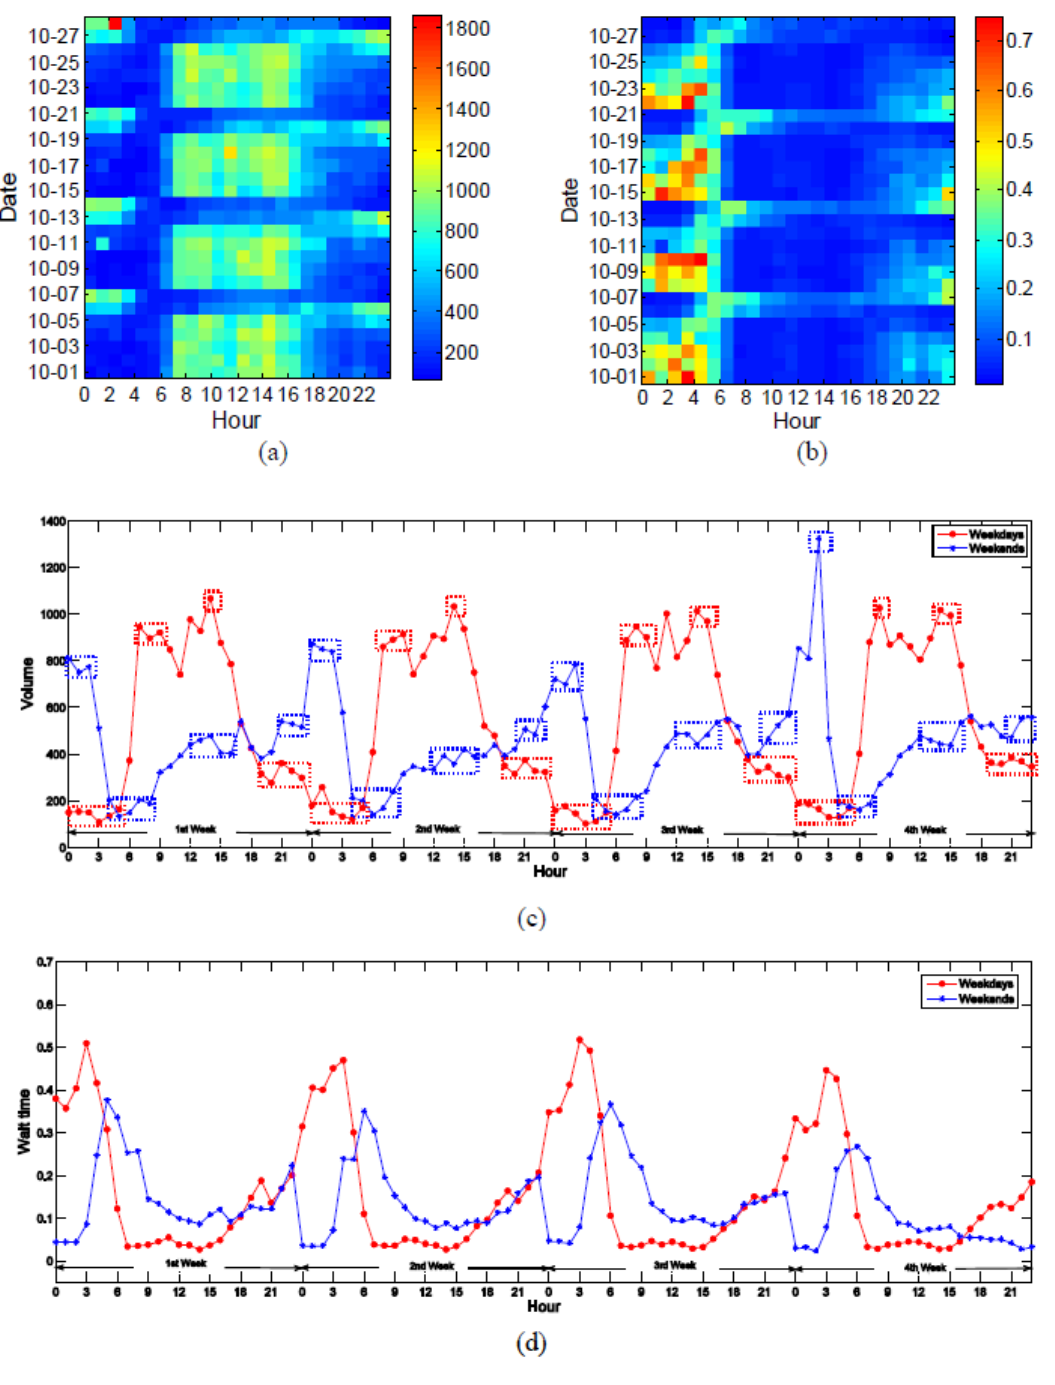
Figure 4. Human activities changing on an hourly basis (Note: ( a ) shows the CTS for SPs volume, where we can clearly observe the activities pattern of the local residents repeats daily and weekly. Worthy of note is that the date 07-10-07 was a Sunday; ( b ) demonstrates the CTS for SPs wait time, where the pattern exhibits the opposite characteristic as that shown in (a); ( c ) plots hourly based change of average SPs volume on weekdays and weekends respectively, and the dot-box represents the period of relative bursts or silence of activities; ( d ) plots the hourly based change of the average SPs wait time on weekdays and weekends respectively but displays an opposite trend to